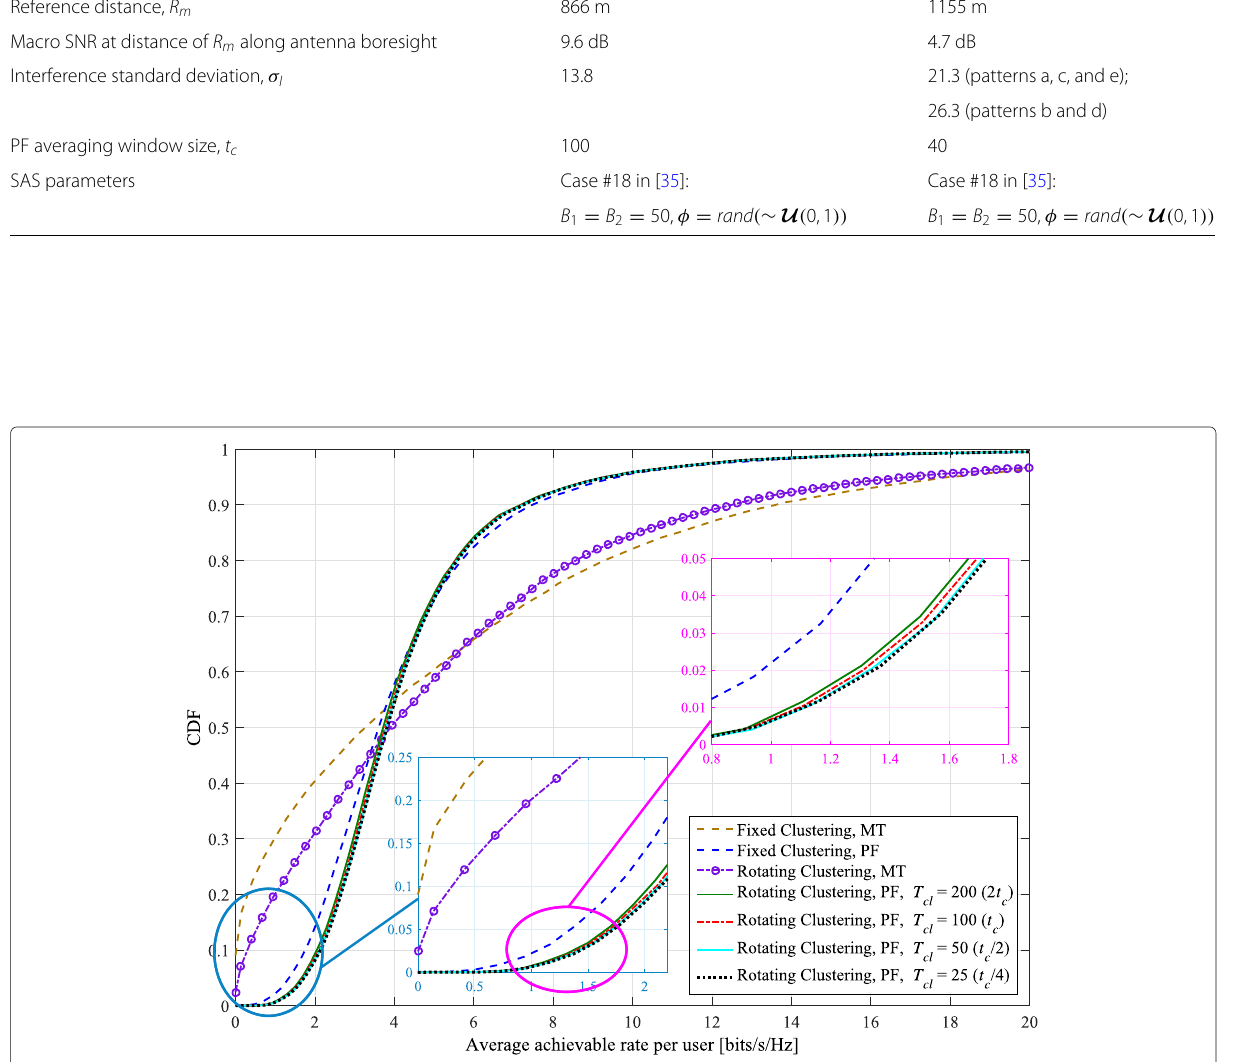
Fig. 3 CDF of average achievable per-user rate with both proportionally fair (PF) and maximum throughput (MT) scheduling metrics, comparing proposed rotating clustering scheme and fixed clustering for six-cell layout, using simulated annealing scheduling and SZF-DPC precoding. K c = 12, N macro = N pico = 2, M =